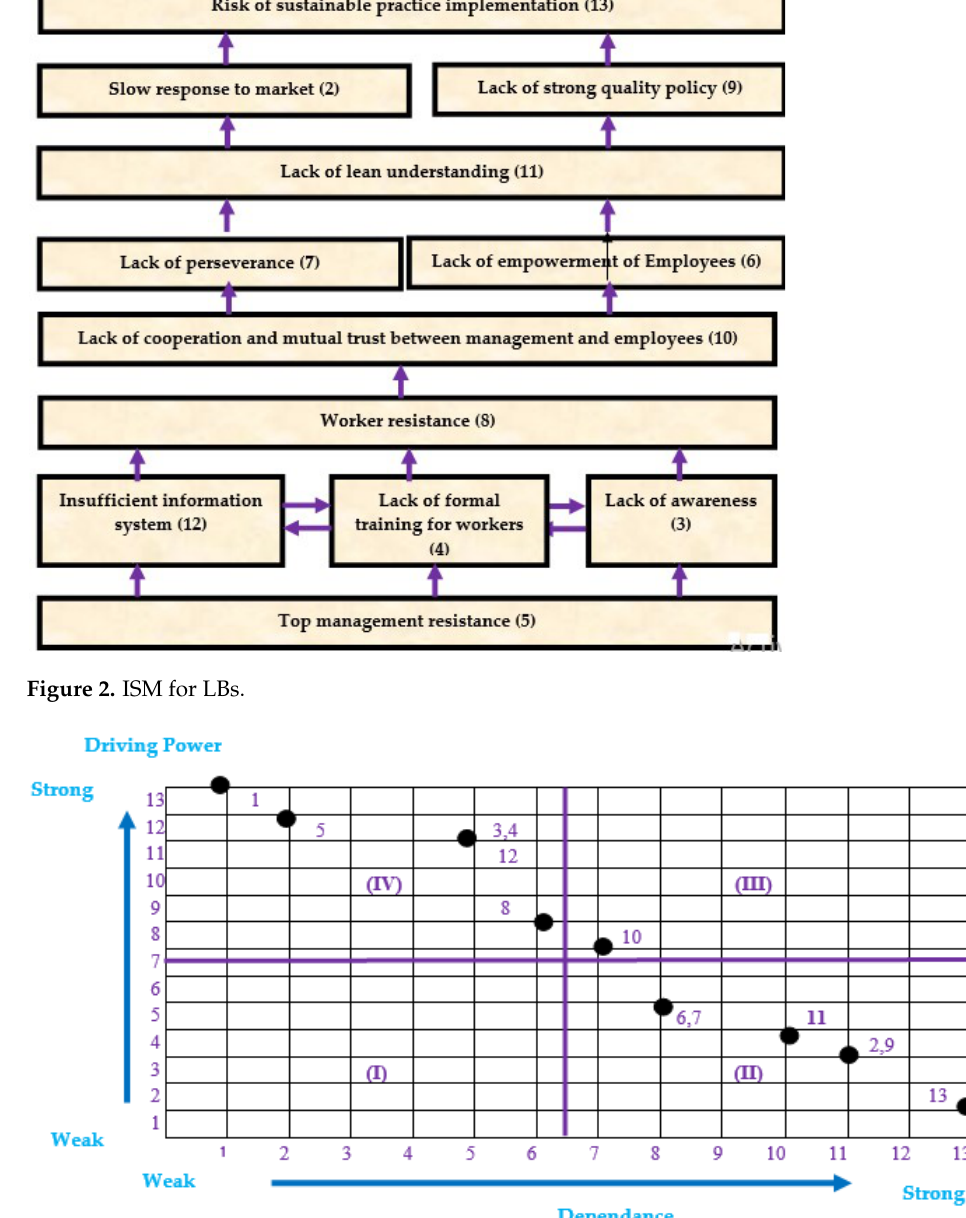
Figure 3. Classification of LBs using MICMAC analysis.